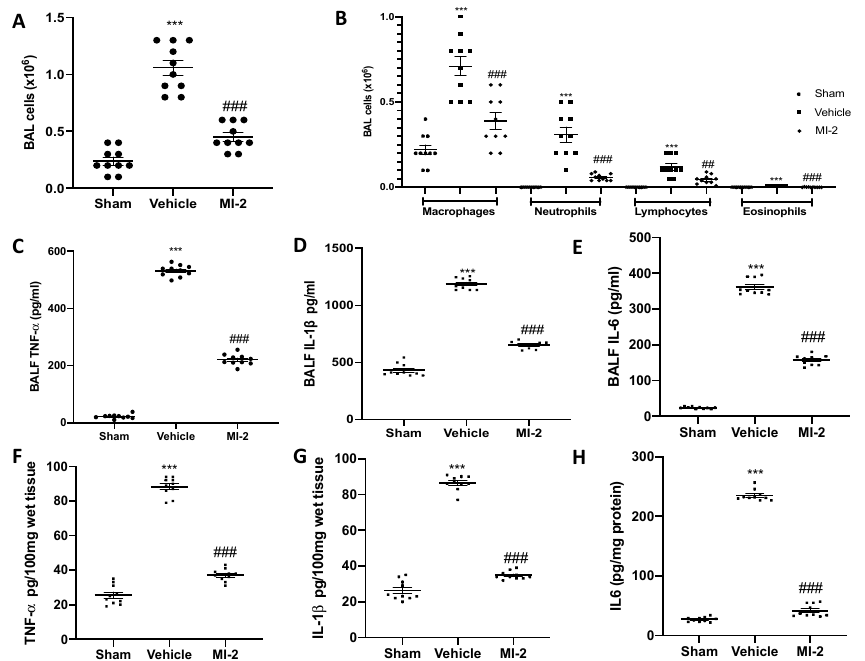
Figure 4. Effect of MI-2 on cells infiltration and proinflammatory cytokines over-expression: total cells ( A ); macrophages, neutrophils, lymphocytes and eosinophils ( B ); cytokines expression in bronchoalveolar lavage fluid: TNF- α ( C ), IL-1 β ( D ), IL6 ( E ); cytokines expression in lung tissues: TNF- α ( F ), IL-1 β ( G ), IL6 ( H ). For each analysis, n = 10 animals from each group were employed.